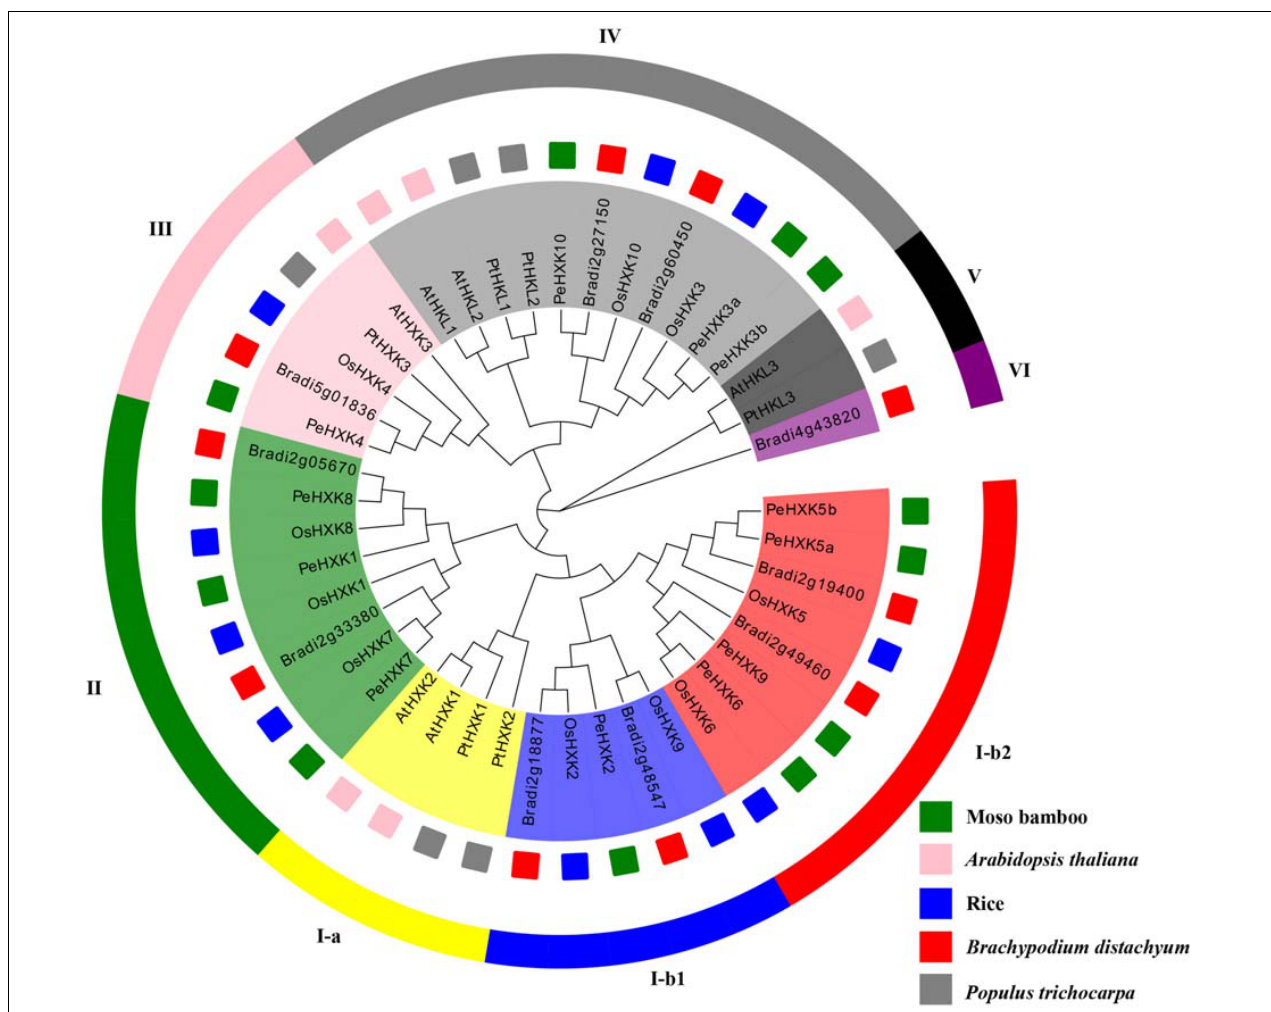
FIGURE 1 | Phylogenetic tree of PeHXK proteins from moso bamboo, Arabidopsis thaliana , rice, Brachypodium distachyon, and Populus trichocarpa . The tree was generated using the Neighbor-Joining (N-J) method with 1000 replicates. The fragments with different colors in the outer ring represent different subfamilies. The small squares with colors inside indicate different species [pink, A. thaliana ; blue, O. sativa (rice); red, B. distachyon ; green, moso